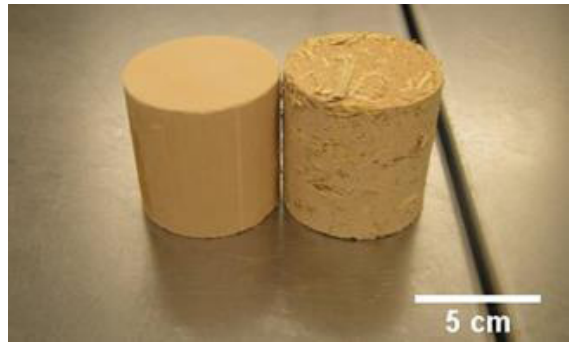
Figure 1. Manufactured specimens of FWAS‐S0% (left) and FWAS‐S3%